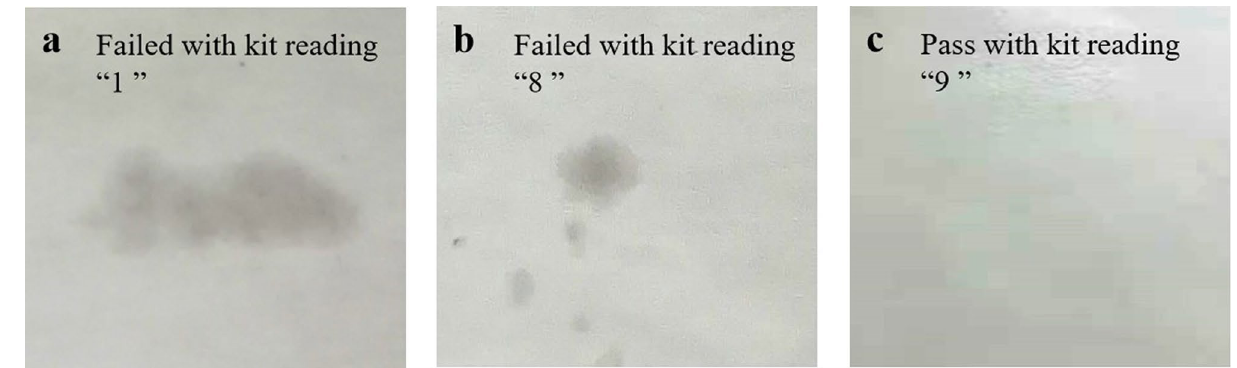
Figure 6. Images of kit testing of ( a ) base paper, ( b ) PVA coated paper, and ( c ) PVA/CNF coated paper.